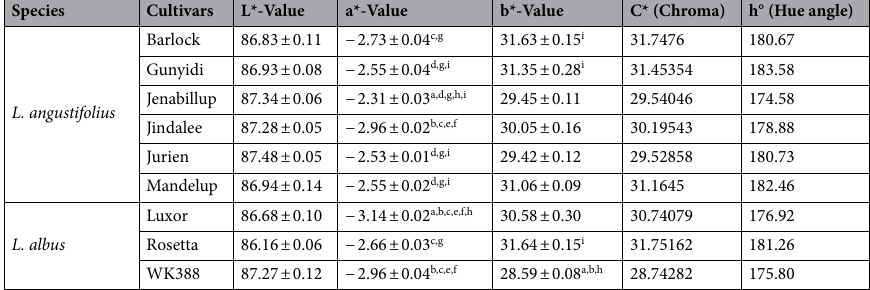
Table 1. Color evaluation of different lupin cultivars. Data are means of three replicates with standard deviations (SD). Data within the same column with different superscripts are significantly different, pair-wise comparison by Post Hoc Tukey test ( a P < 0.05 vs. Barlock; b P < 0.05 vs. Gunyidi; c P < 0.05 vs Jenabillup; d P < 0.05 vs. Jindalee; e P < 0.05 vs Jurien; f P < 0.05 vs. Mandelup; g P < 0.05 vs Luxor; h P < 0.05 vs Rosetta; i P < 0.05 vs WK388). C* and h° are calculated using the means of L*, a*, b*